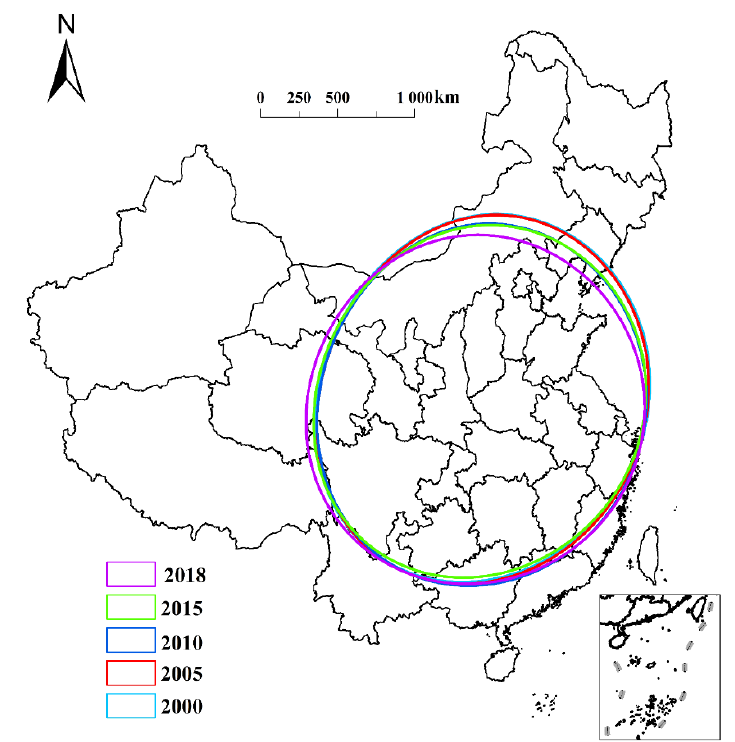
Figure 2. Trend of non-grain production rate in China from 2000 to 2018.